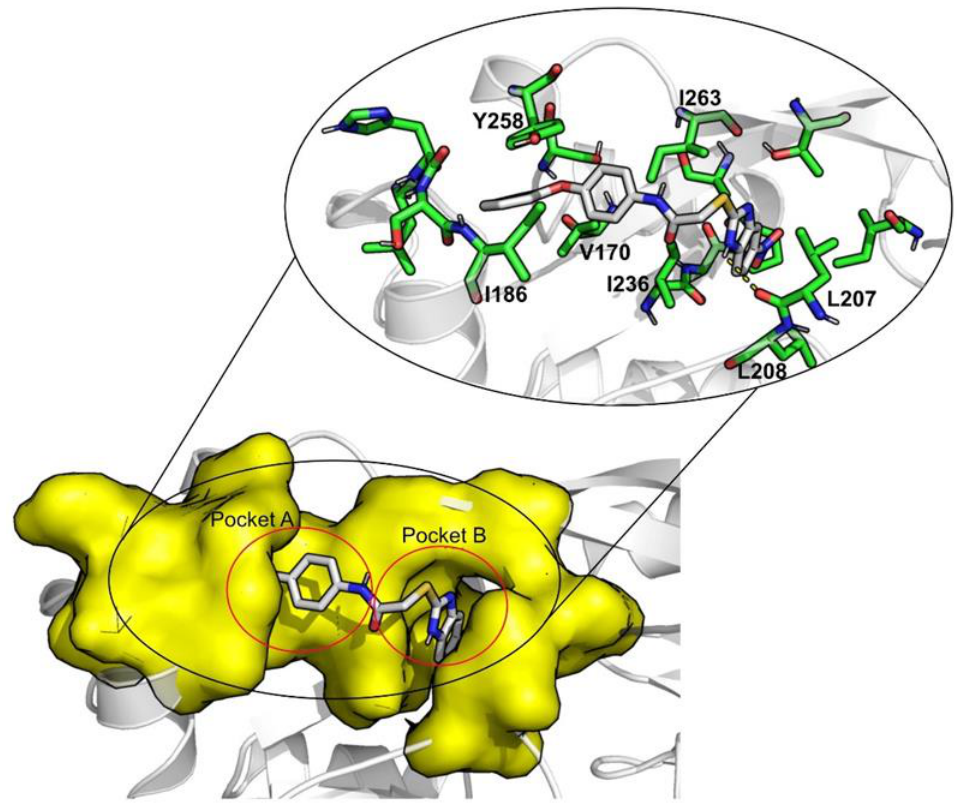
Figure 4. 6B8A – M64 interaction map. Figure 4. 6B8A–M64 interaction